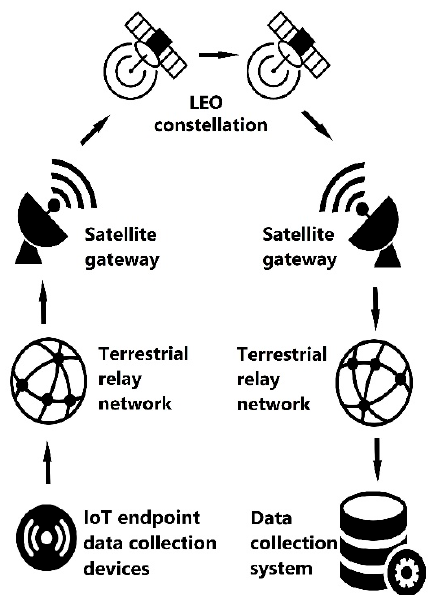
Figure 1. Conceptual Internet of things (IoT)-satellite network Figure 1 . Conceptual Internet of things (IoT)-satellite network architecture.